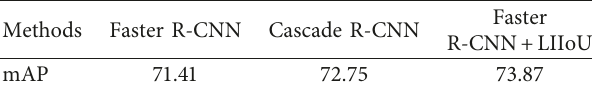
Table 2: Experiments on length-independent interaction ratio and interaction ratio on DOTA verification